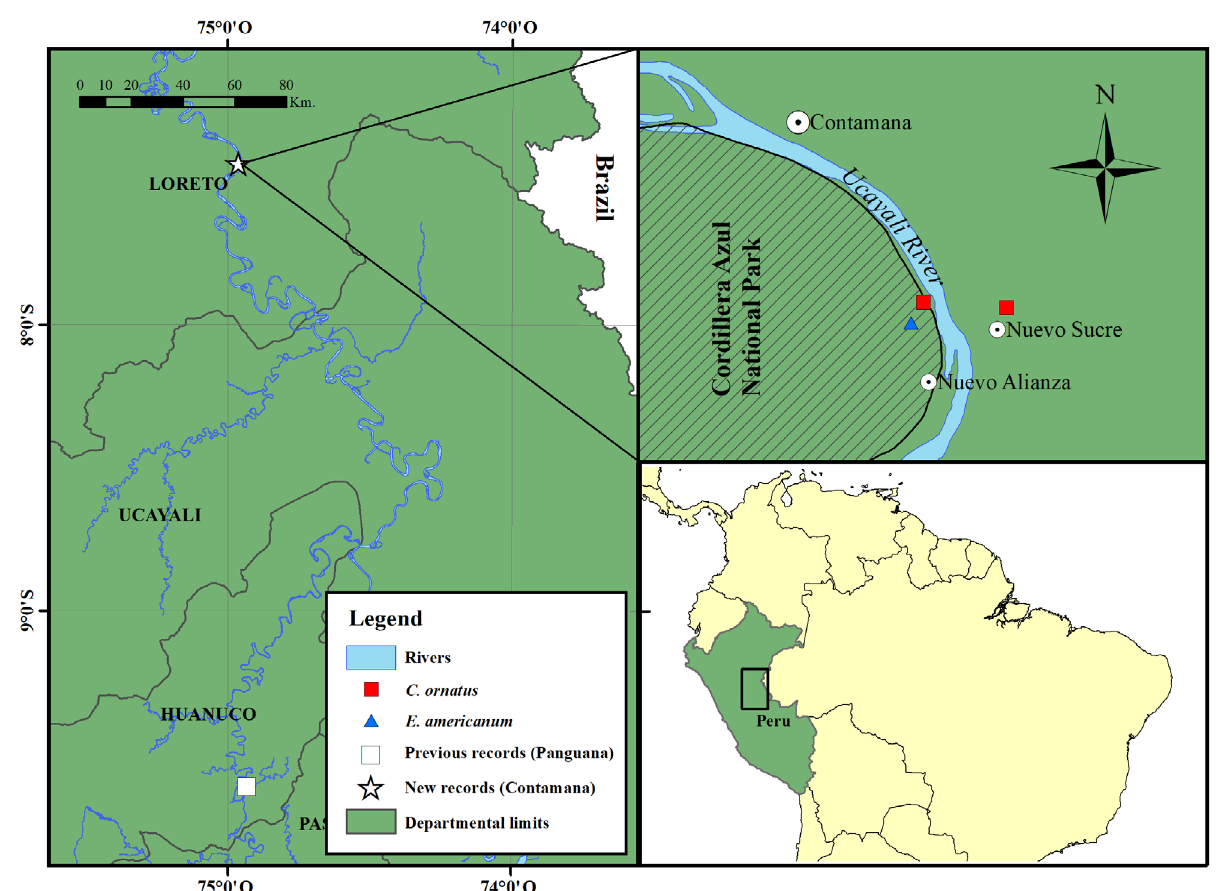
Figure 1. Map of the study area showing the collection sites of Nueva Alianza and Nuevo Sucre, Contamana, province of Ucayali, department of Loreto, Peru. The white square indicates previous records of Circoniscus ornatus , and the white star indicates the new records of Circoniscus ornatus and Ethelum americanum